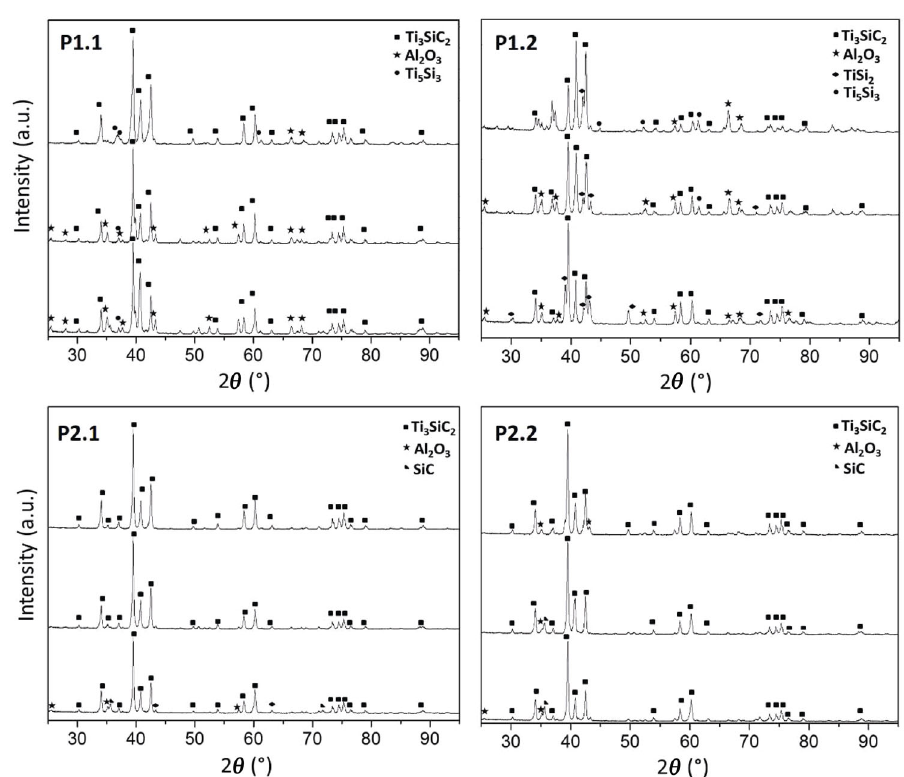
Fig. 5 X-ray diffraction patterns of films formed from all paste compositions after sintering at 1400 ℃ for 1, 3, and 5 h. 5 h of sintering and paste P2.2 after sintering for 5